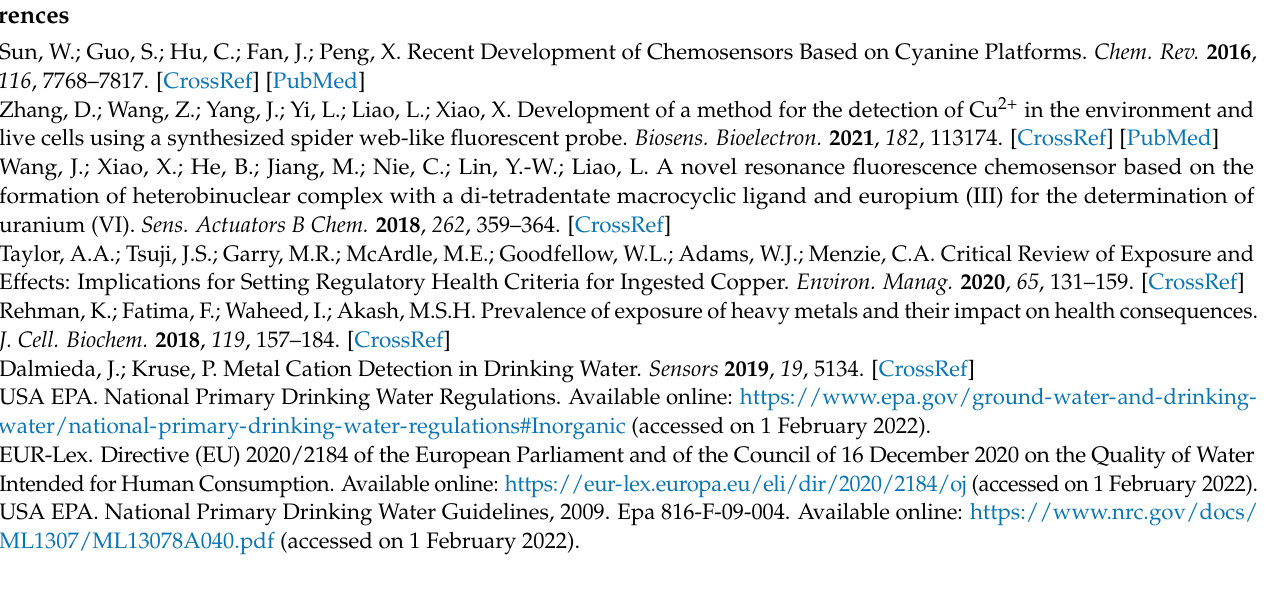
Figure S5: Naked-eye assessment of the colourimetric selectivity of Cy1 (1 × 10 − 5 M) for Cu